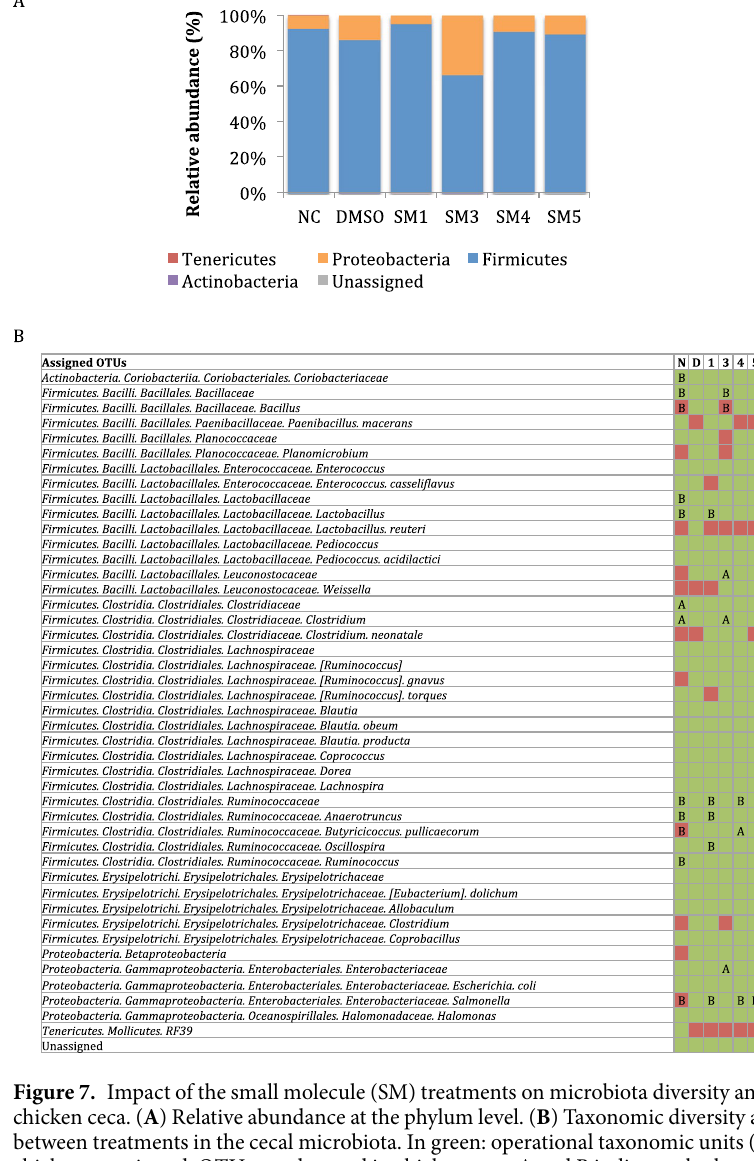
effects on the antimicrobial activity of antibiotics (ciprofloxacin, meropenem, and cefeprime) currently used to control Salmonella in animal production and human infections. For example, the combination of a sub-lethal dose of both SM1 and ciprofloxacin reduced the ciprofloxacin MBC from 0.0625 µ g/ml to 0.001 µ g/ml. A reduc- tion in antibiotics’ uses would contribute to mitigation and also reduce the emergence of antibiotic-resistant bac- teria, thereby reducing the economic burden associated with infections due to antibiotic-resistant bacteria 26,27 . It was also found that at 200 µ M, SM5 did not affect the growth of Bifidobacterium longum , Lactobacillus brevis , and Lactobacillus rhamnosus GG , which are known to have anti- Salmonella effects (data not shown) 28–30 . Thus, SM5 could be combined with these probiotics to enhance the control of Salmonella in poultry production systems. The combination of two control methods would also reduce the risk for Salmonella developing resistance to these complementary approaches. All four SMs disrupted the Salmonella cell membrane when the bacteria were challenged with a lethal dose of SMs, causing significant leakage of cellular content 31 . Specifically, SM1, SM3, and SM4 affected S . Typhimurium cell membrane integrity. A previous study showed a similar effect when E. coli was treated with peptoids contain- ing tryptophan-like side chains, which have strong affinity for membranes 32 . SM1 and SM5 contain a benzimida- zole group, an analogue of tryptophan; and SM3 is composed of an imidazole group, which is a component of a benzimidazole group 33 . Similar phenotypic alteration of the membrane integrity was also described when E. coli